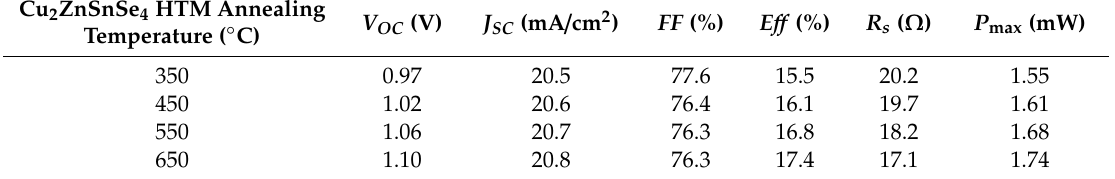
Figure 10. The J – V curves of Ag / IZO / ZnS / MAPbI 3 / Cu 2 ZnSnSe 4 / Mo / FTO nanostructured solar cells, under 100 mW / cm 2 illumination. The IZO layer thickness has been 100 nm. Table 3. The PV characteristic parameters of the Ag / IZO / ZnS / MAPbI 3 / Cu 2 ZnSnSe 4 / Mo / FTO nanostructured solar cells.